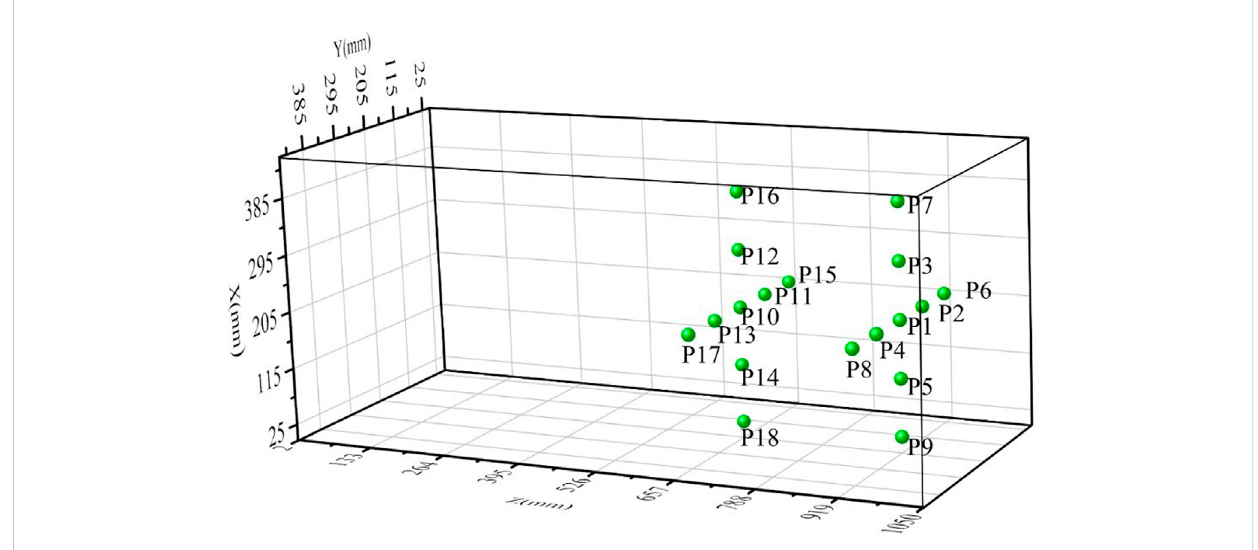
FIGURE 3 Schematic diagram of gas pressure sensor installation